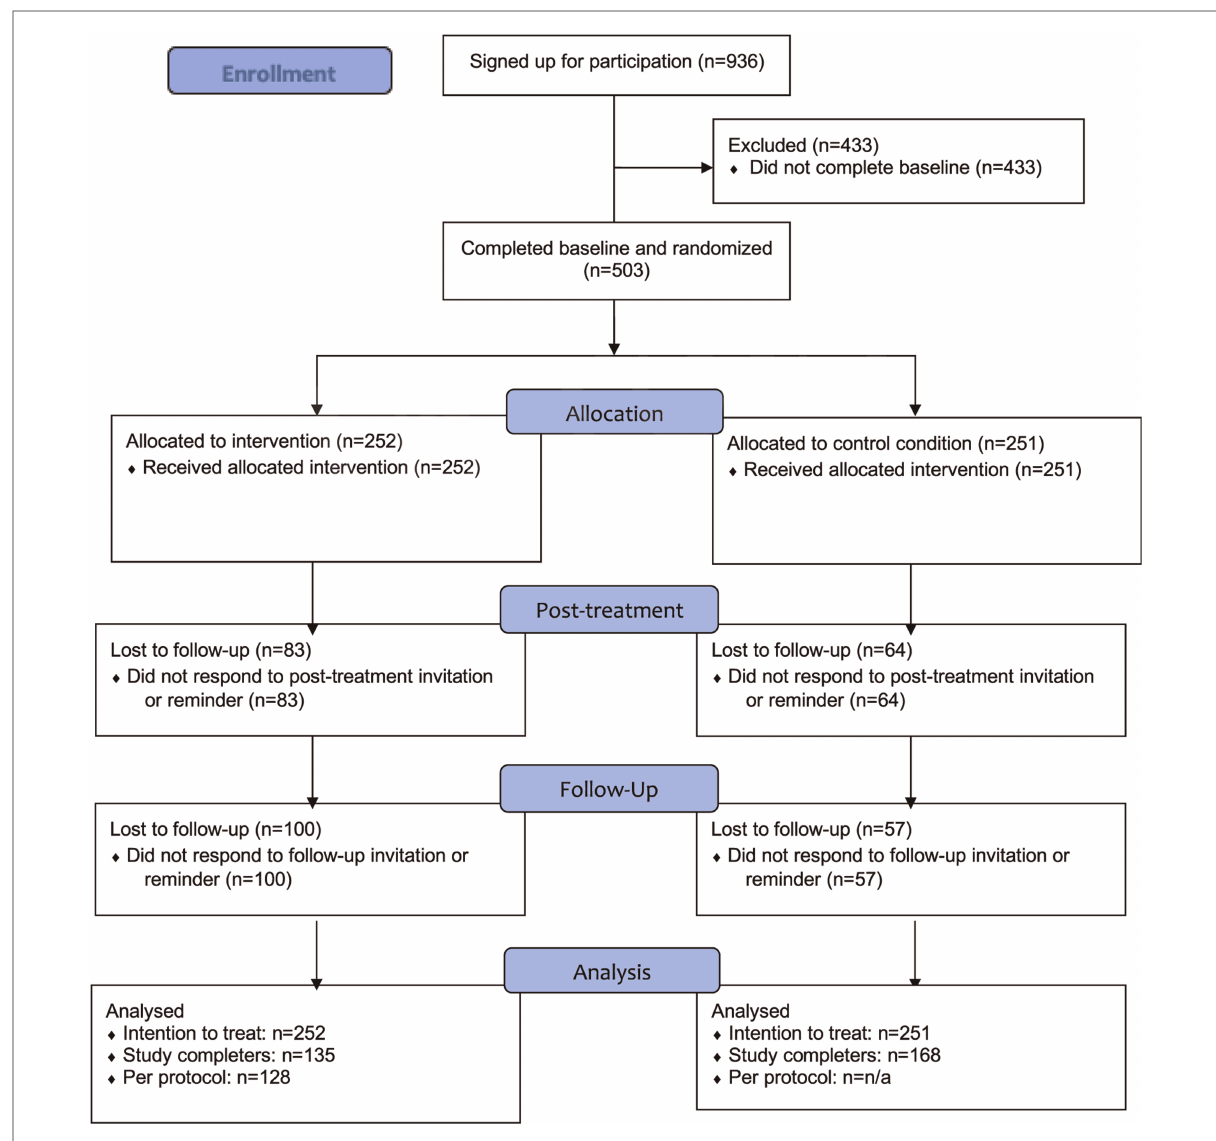
FIGURE 1 CONSORT fl ow diagram. Participants who did not complete post-treatment assessment were still allowed to complete the follow-up